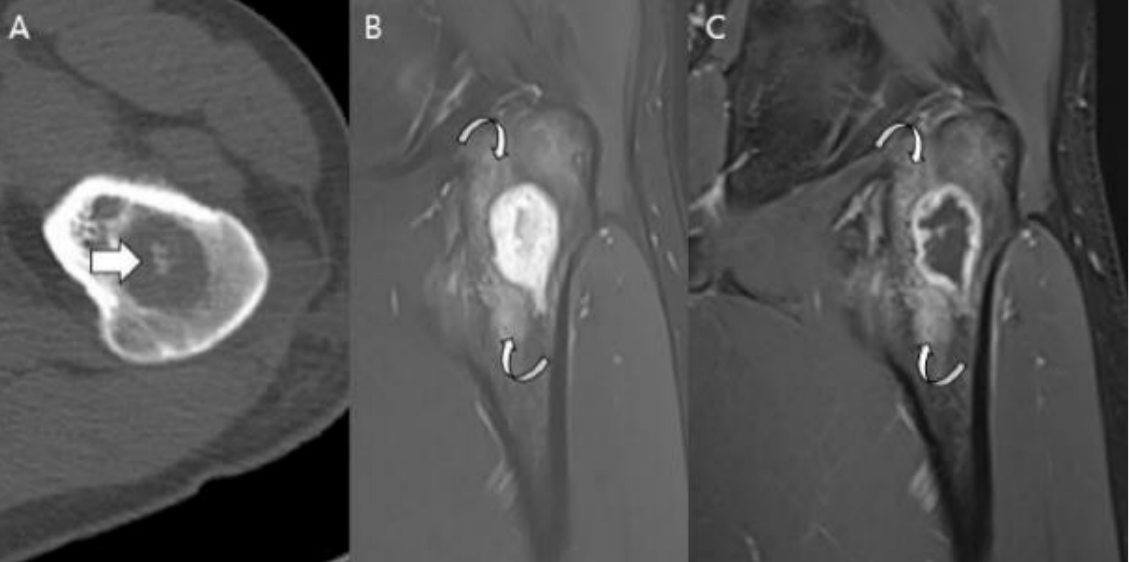
Figure 15. Atypical cartilaginous tumor of the proximal femur in a 22-year-old man. ( A ) Axial CT scan reveals a low-density intramedullary mass with chondral-type mineralization (arrow) in the proximal femur. ( B , C ) Coronal T2-weighted fat-suppressed and T1-weighted enhanced images show an intramedullary mass of 3 cm in size with high signal intensity and the peripheral rim and septal enhancement. Note the peritumoral edema with enhancement (curved arrows).